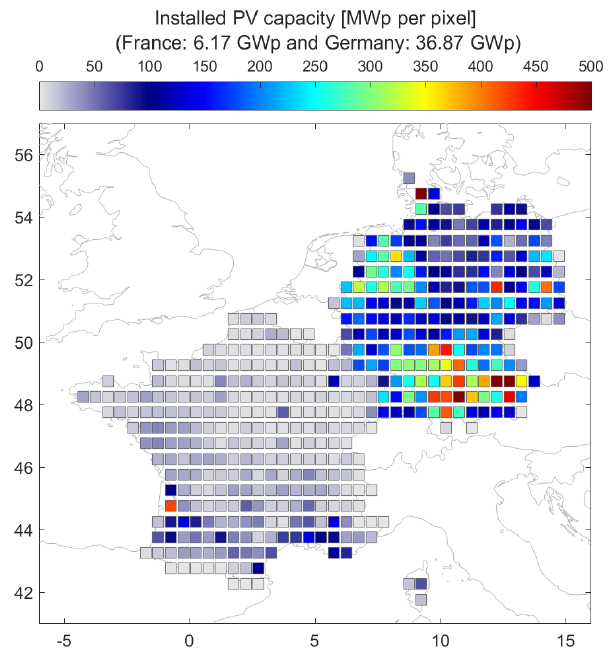
Figure 5. Spatial distribution of the installed PV capacity in France and Germany for the year 2014. The installed capacity is aggregated on the pixel used for the calaculation which have a resolution of 0.5 ◦